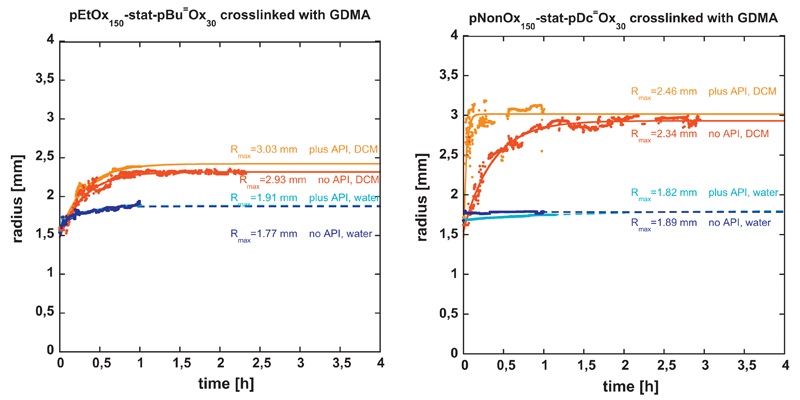
Optometrically determined radii changes during the swelling of
pEtOx150-stat-pBu⁼Ox30 (left)
and pNonOx150-stat-pDc⁼Ox30
(right) (both crosslinked with GDMA) in water and dichloromethane (DCM).